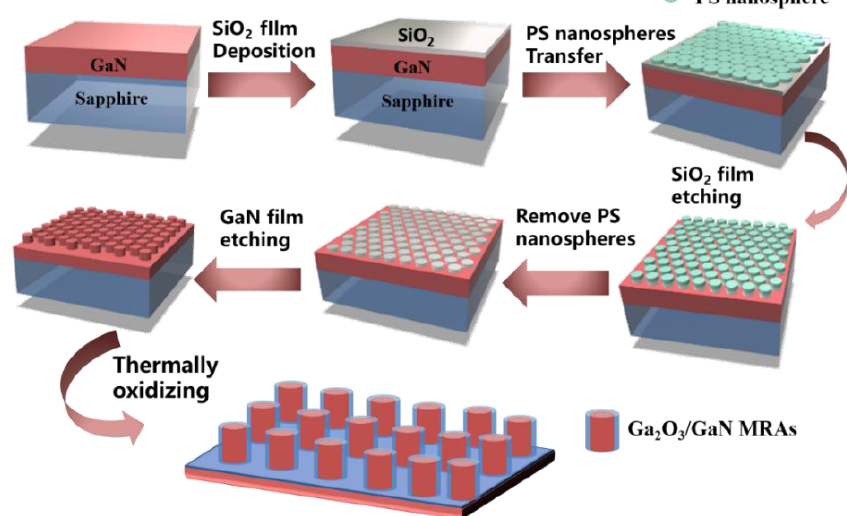
Figure 1. Schematic of the Ga 2 O 3 /GaN MRAs fabrication.